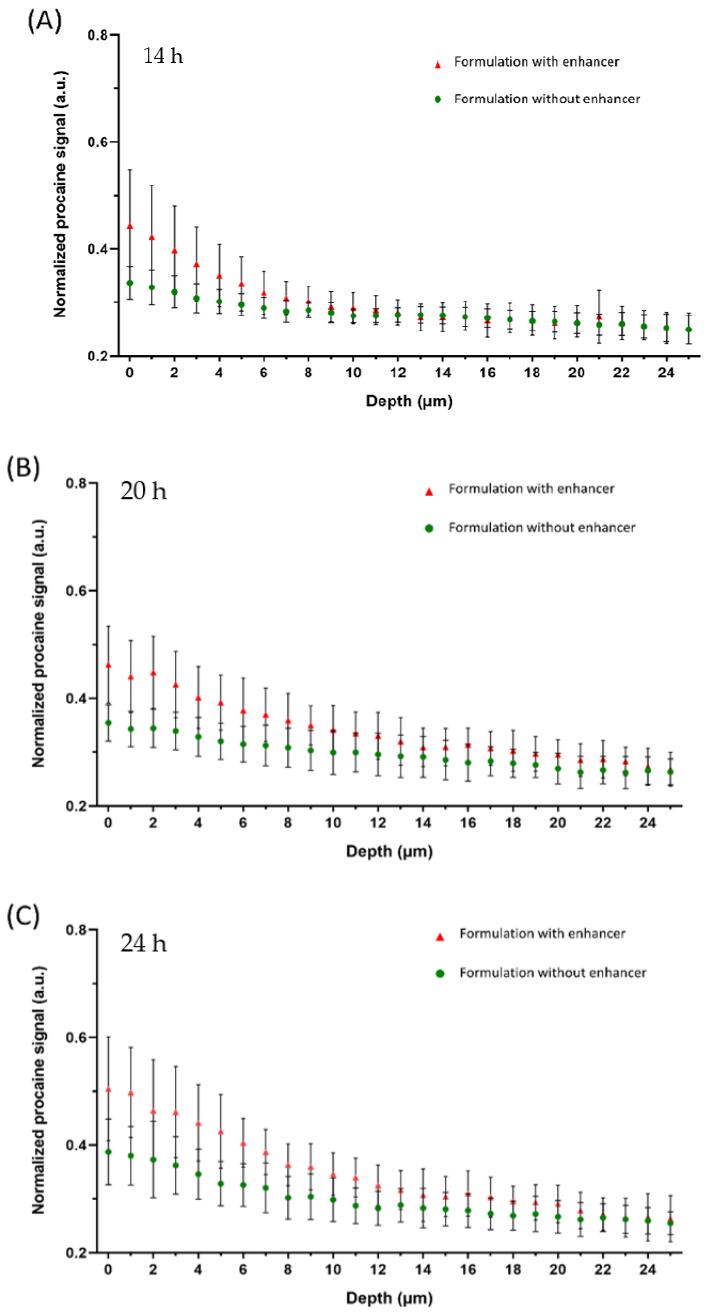
Figure 4. Penetration profiles of procaine HCl in porcine skin after the skin incubation time of 14 h ( A ), 20 h ( B ) and 24 h ( C ) with the measurements of the off-line device. Two procaine-HCl containing formulations were compared: formulation with enhancer (red triangles) and without enhancer (green circles). Mean ± SD ( n ≥ 9).